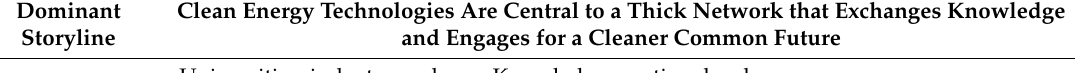
Table 2. Overview of the dominant